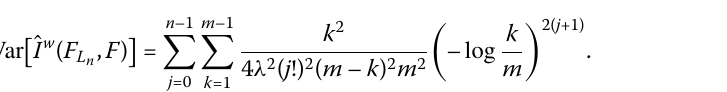
, F )] for beta distribution